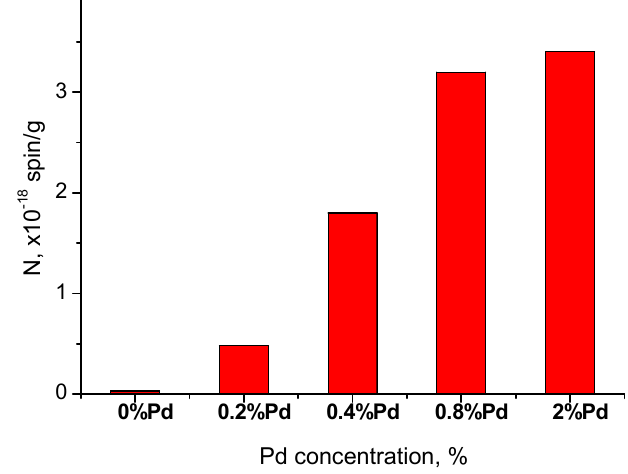
Figure 8. Concentration of TNB radical anions on surface of x% Pd/ZrO 2 catalyst with various concentration of the supported Pd (x, wt %). T act = 300 °C.